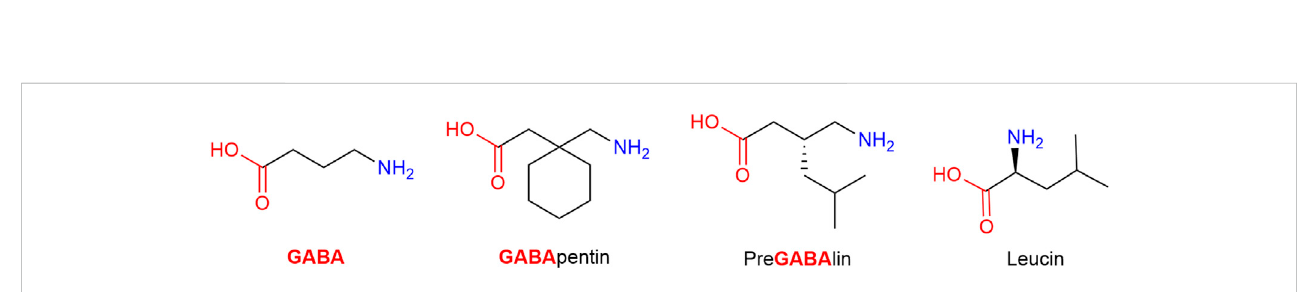
FIGURE 11 Structurally gabapentin and pregabalin are related to the endogenous inhibitory neurotransmitter GABA and to the amino acid leucine.